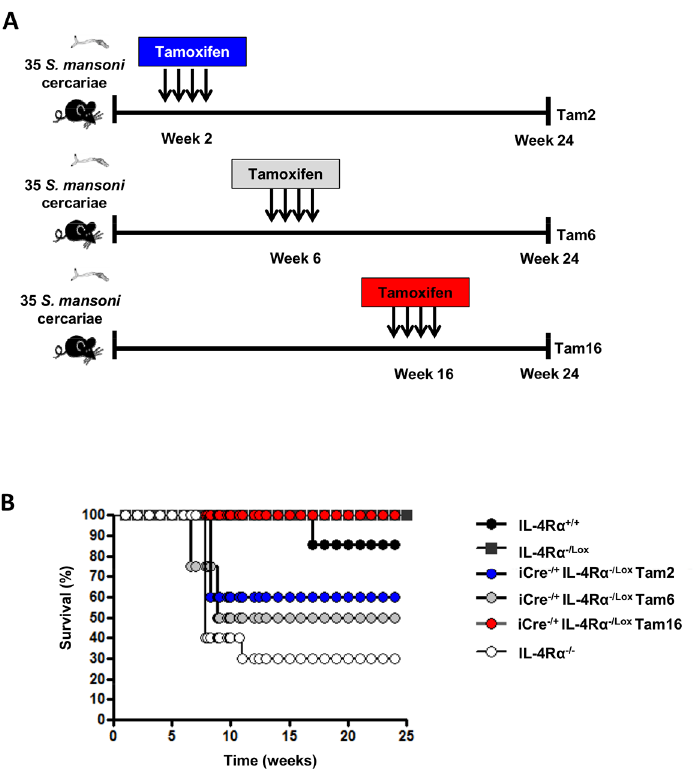
Fig 3. Different phenotypes after knocking down IL-4R α at different phases of experimental schistosomiasis. A. Experimentaldesign. B. Survival curve representingthe cumulative profile from 2 different infections(n = 5–10